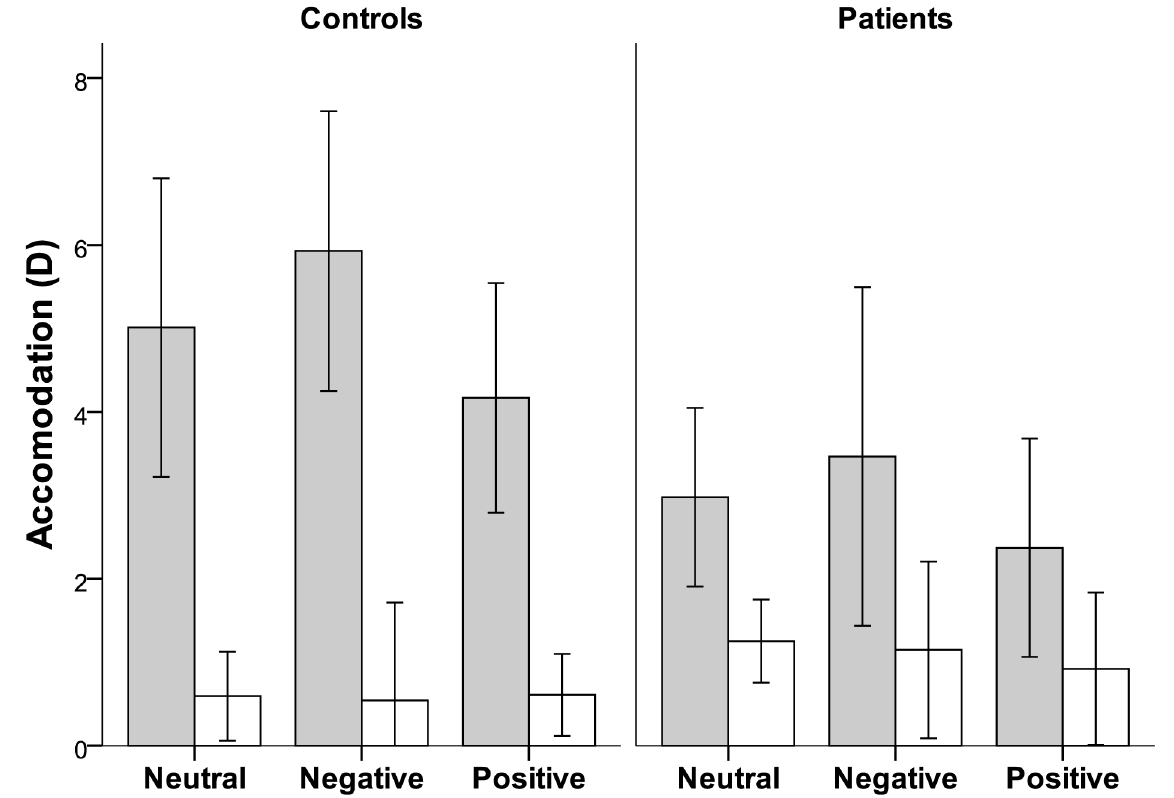
Fig 3. Accommodation response. Mean accommodation (and 95% confidence intervals), for the control group and for the patient group, from the periods with Near (grey bars) and Far (white bars) focusing for the three viewing